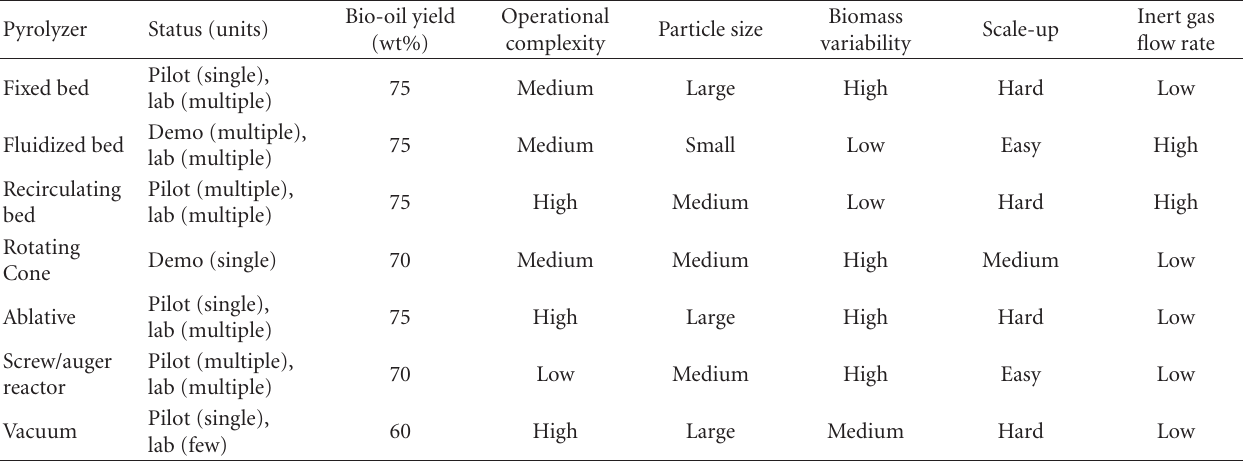
Table 4: Comparison of various biomass pyrolysis reactors based on overall performance and e ffi ciency.